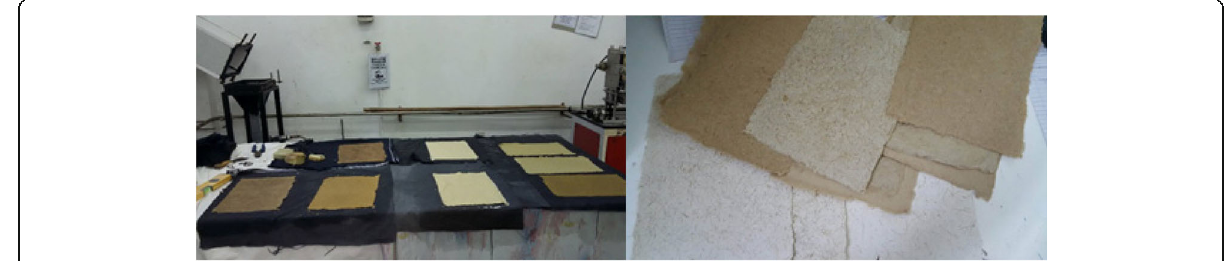
Fig. 3 Sheet of paper left to dry at ambient conditions and dry ironed sheets of paper